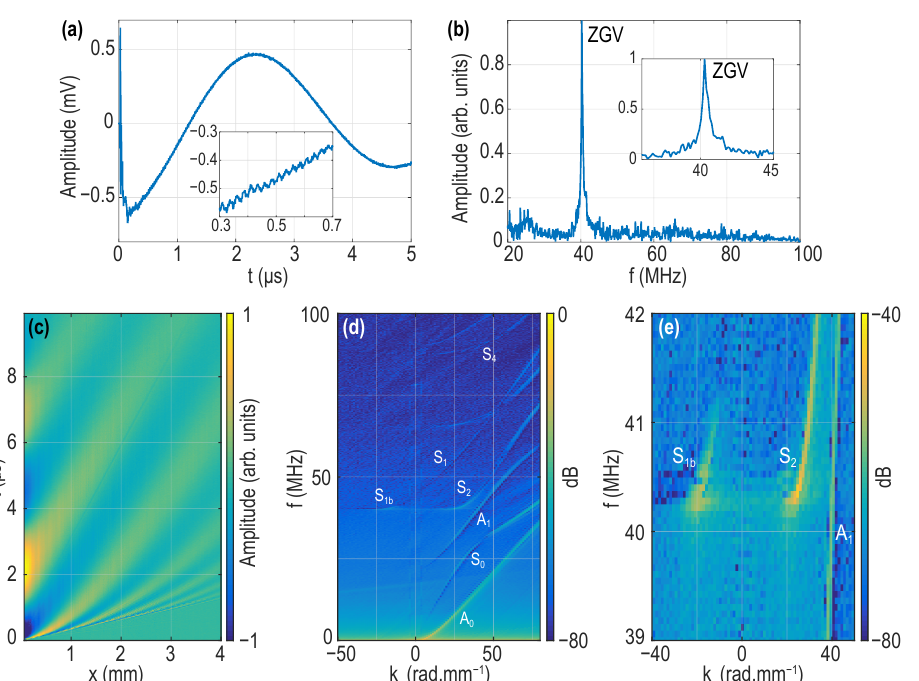
Figure 3. ( a ) A typical measured signal in the aluminum plate and ( b ) its spectra. ( c ) Spatiotemporal measurements (B-scan) obtained in Configuration (2) of the experimental setup (see Figure 2c). ( d ) Wavenumber-frequency diagram obtained by a 2D Fourier Transform of the B-scan shown in ( c ). ( e ) Zoomed-in part of ( d ) around the S 1 S 2 -ZGV